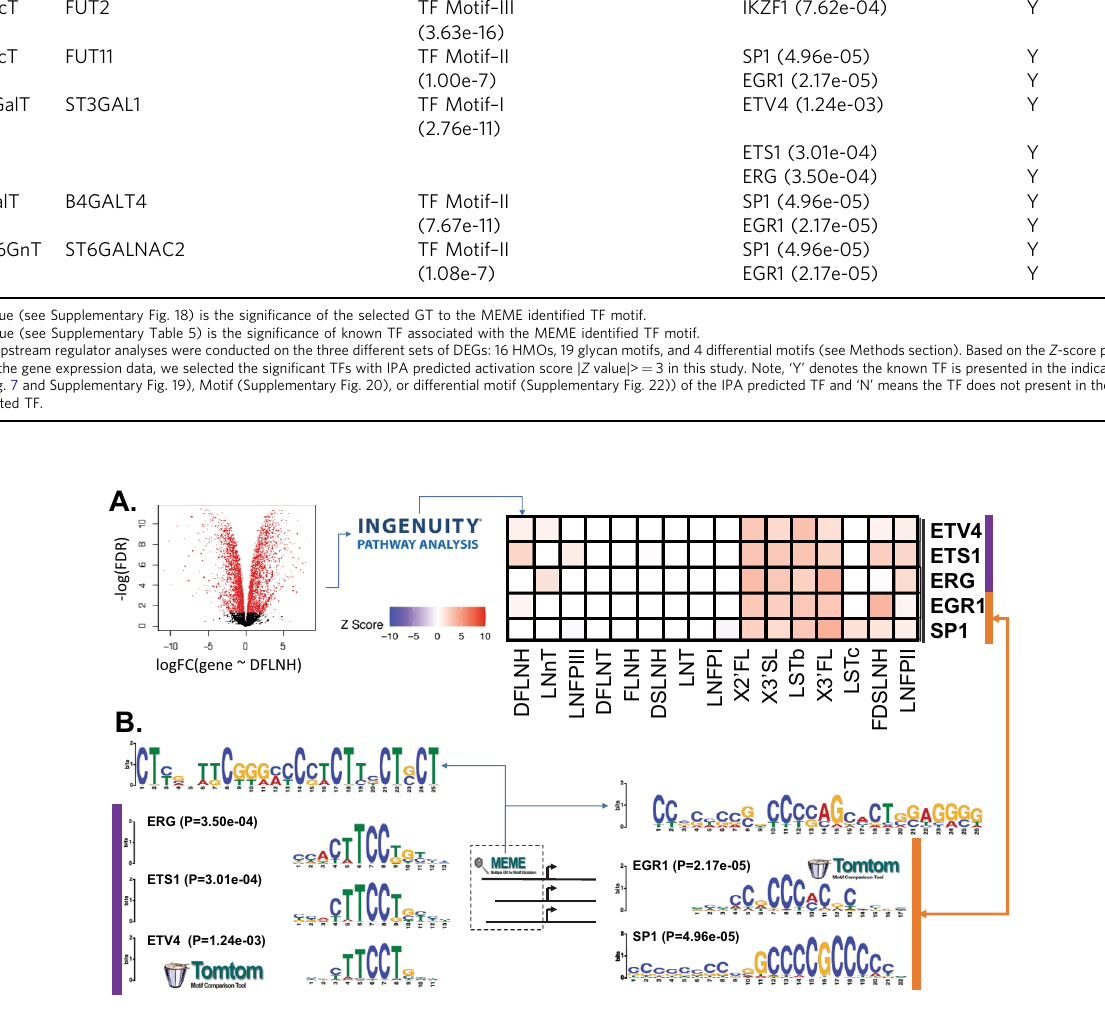
Fig. 7 de novo promoter-enriched TF motifs and IPA predicted TFs using differential expression analyses with respect to 16 HMOs. A MEME identi fi ed TF motifs and 5 known TFs (ETV4, ETS1, EGR1, SP1, and ERG) associated with them (see Supplementary Table 4). MEME-discovered TFs were cross- referenced with known TF binding sites using TOMTOM. Logos for the matched known and discovered motifs are shown in the top and bottom of each subpanel; the p -value is a logo matching signi fi cance calculated by TOMTOM. B Subset of a biclustering of activation z-score computed by IPA indicating the likelihood that a TF activates ( z > 0) or inhibits ( z < 0) an HMO concentration signature (gene expression associated with changes in HMO concentration). The full biclustering can be found in the supplement (Supplementary Fig.